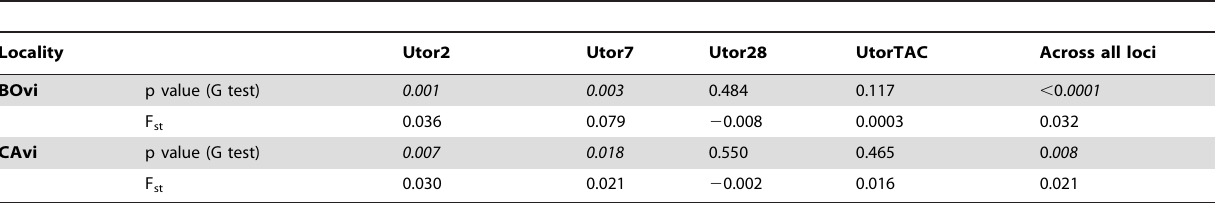
Table 6. Temporal differentiation in population structure of Utetheisa ornatrix .